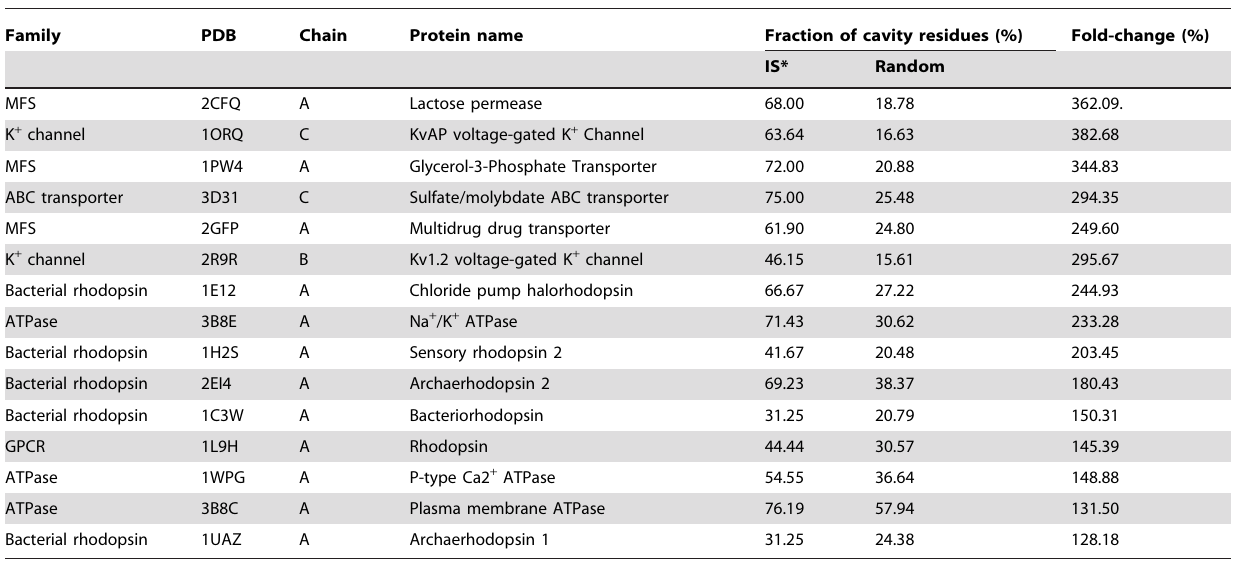
Table 2. List of the membrane protein